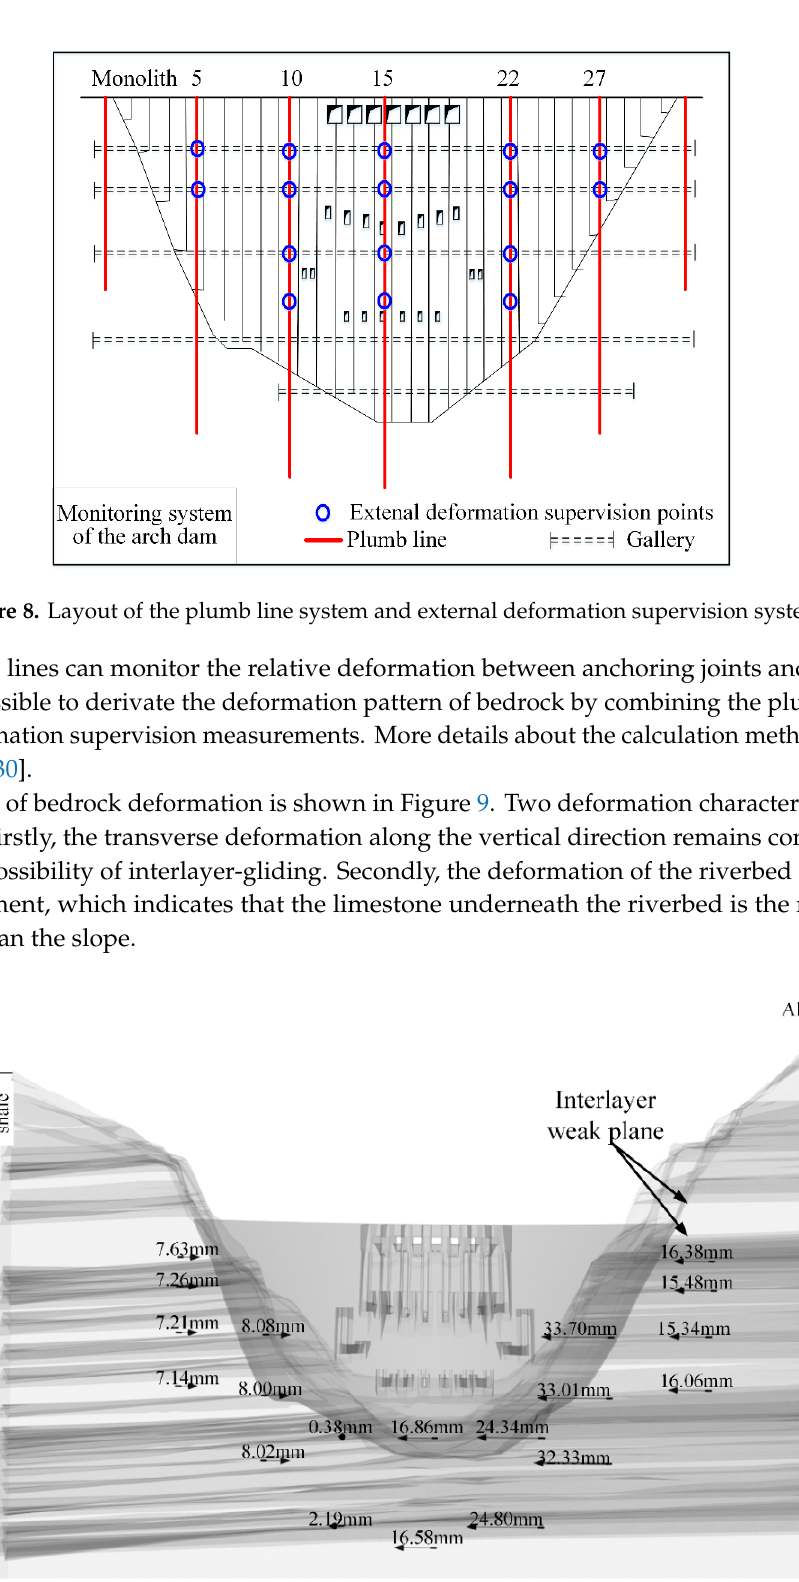
Figure 9. Horizontal deformation pattern of the rock base (upstream view, November 2012– November 2019).